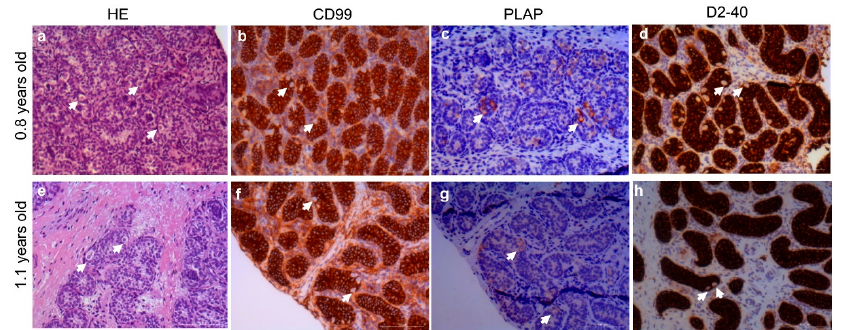
Figure 1. Hematoxylin and eosin ( HE) staining and immunohistochemistry by CD99, PLAP and D2-40 in undescended testis aged 0.8 and 1.1 years old, respectively. HE staining ( a,e ); CD99 immunohistochemistry ( b,f ); PLAP immunohistochemistry ( c,g ); D2-40 immunohistochemistry ( d,h ); Arrows show the germ cells. CD99: cluster of differentiation 99; PLAP: placental alkaline phosphatase, D2-40: podoplanin; Scale bars: 100 µm.